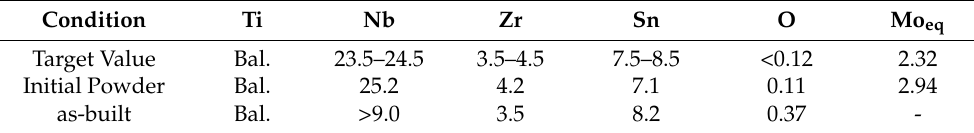
Table 1. Chemical composition of initial powder and LPBF manufactured Ti2448 alloy in wt.